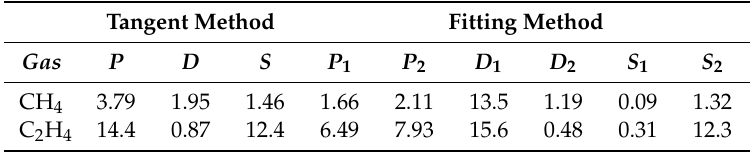
Figure 5. Permeation curve in the Pebax ® 1657 / Cu II 2 (S,S)-hismox MMM at 1 bar for C 2 H 6 ( a ) and C 2 H 4 ( b ) and their fits using Equation (4). Alternative two-stage fit of the permeation curve of C 2 H 4 with the first stage ( c ) and second stage ( d ) fits using Equation (8). The shaded area denotes the residuals of the fit of the start of the permeation curve and can be fitted as a typical time lag curve in the second stage. Table 1. Permeability [Barrer], Di ff usion coe ffi cient [10 − 12 m 2 s − 1 ] and Solubility [cm 3 STP cm − 3 bar − 1 ] of the Pebax ® 1657 / Cu II 2 (S,S)-hismox mixed matrix membrane at 25 ◦ C and 1 bar of feed pressure determined by the tangent and the fitting methods (double Time